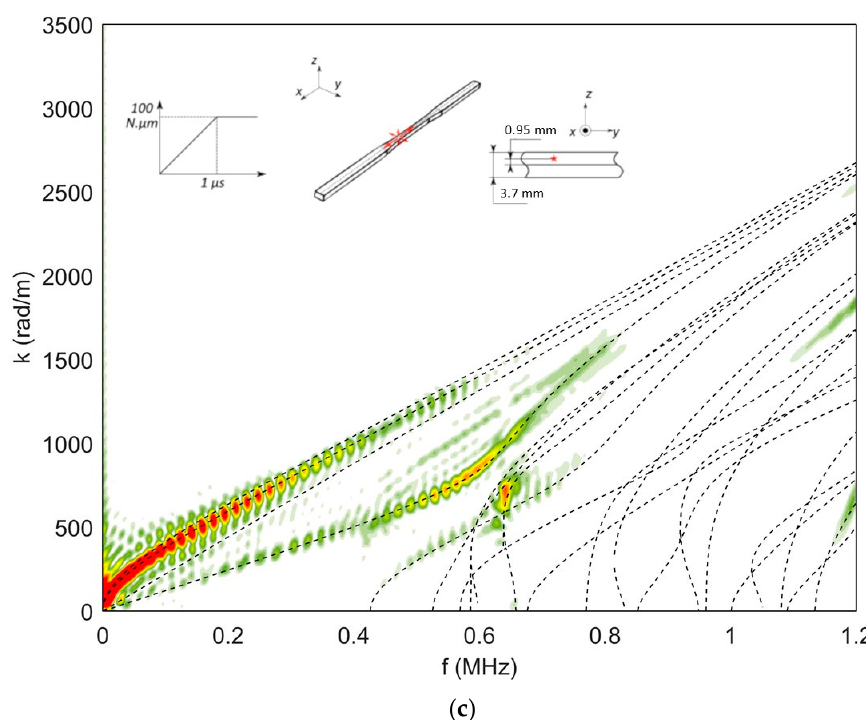
Figure 10. 2DFT (wavenumber k versus frequency f ) of simulated signals for EPL3 specimen stimulated by source D 1 (M x = 100 N ∙μ m, 0 mm, 1 μ s) ( a ), D 1 (M x = 100 N ∙μ m, 0.25 mm, 1 μ s) ( b ), D 1 (M x = 100 N ∙μ m, 0.95 mm,1 μ s) ( c ).